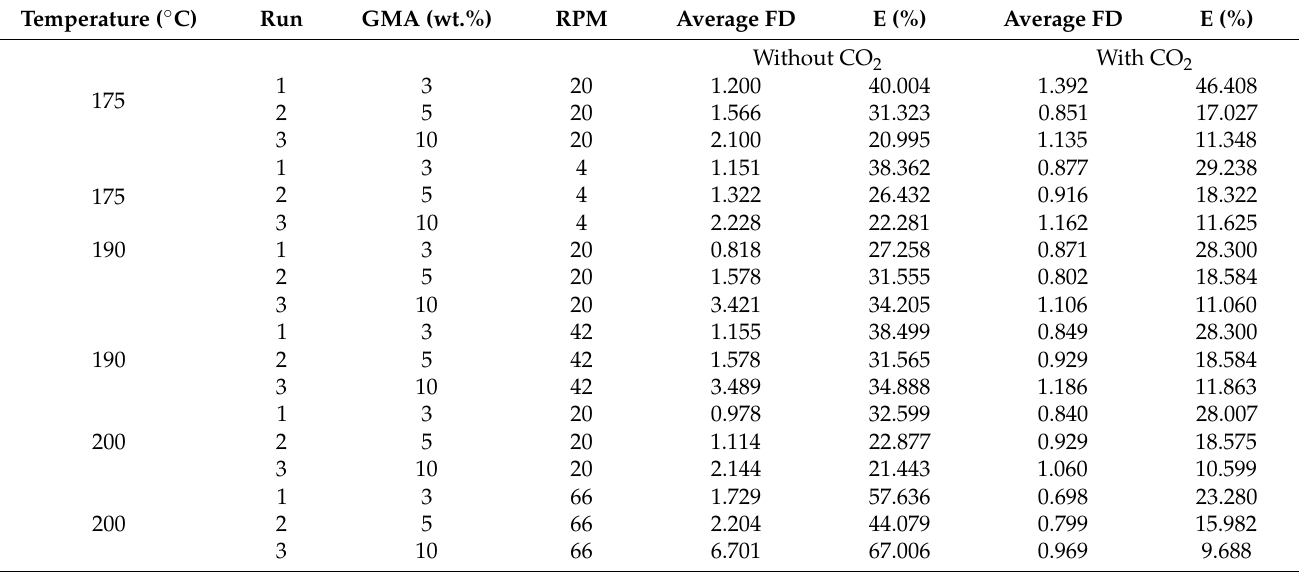
Table A2. Effect of temperature and rotational screw speed on recycled PE-g-GMA. PscCO 2 : 130 bar. Flowrate: 4 g/min.